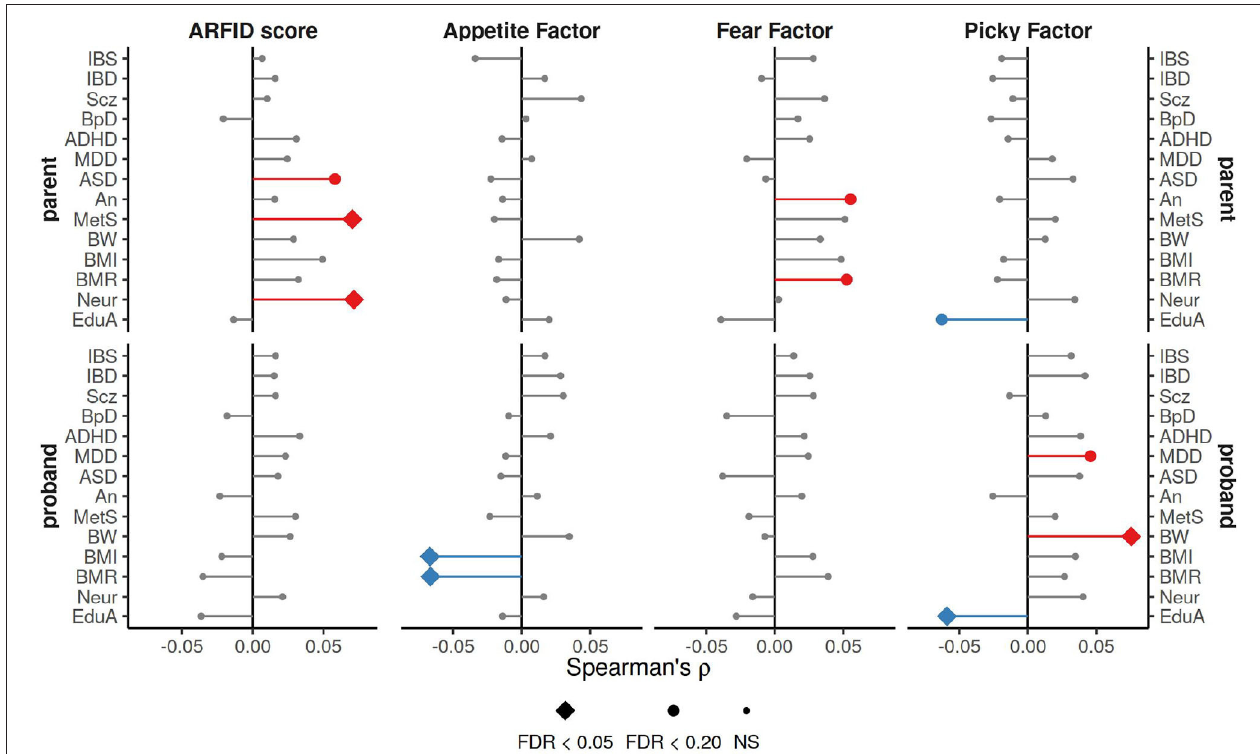
FIGURE 3 | Spearman correlation coefficients for ARFID Score and NIAS factors with PRS for a variety of neuropsychiatric and morphological traits. The strongest association across three p -value thresholds (0.0005, 0.05, and 0.5), is shown here. FDR correction applied across all tests ( n = 336). IBS, irritable bowel syndrome; IBD, inflammatory bowel disease; Scz, schizophrenia; BpD, bipolar disorder; ADHD, attention deficit hyperactivity disorder; MDD, major depression disorder; autism, autism; An, anorexia; MetS, metabolic syndrome; BW, birth weight; BMI, body mass index; BMR, basal metabolic rate; Neur, neuroticism; EduA, educational